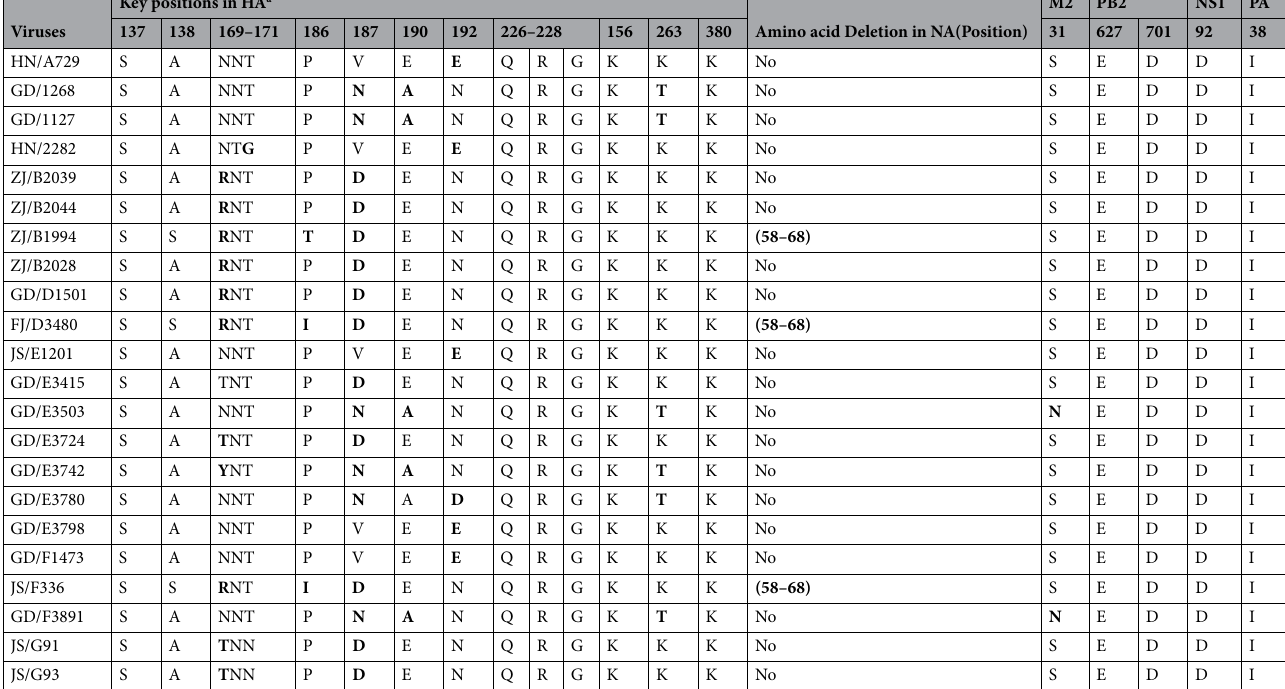
Table 2. Molecular characteristics of H6 viruses. Residues in bold indicate differences from the consensus alignment. a H3 numbers were used